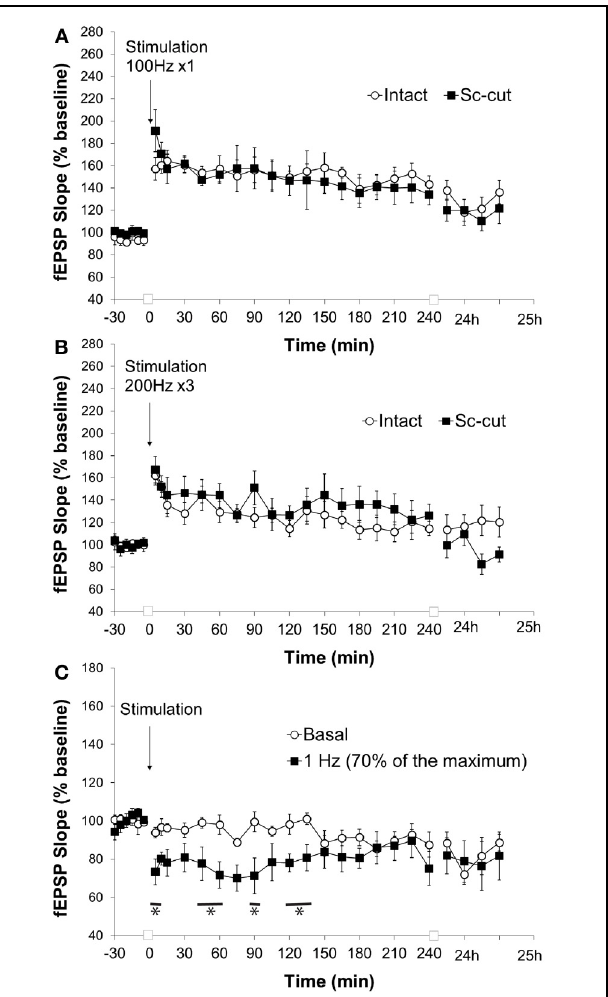
FIGURE 7 | Severence of CA3 input affects the response of the pp-CA1 synapse to LFS but not HFS. (A) High frequency stimulation (HFS) with a weak tetanus of 100Hz (1 burst of 100 pulses) resulted in potentiation in freely behaving rats with intact and Sc-cut conditions. (B) High frequency stimulation with a weak tetanus of 200Hz (3 burst of 15 pulses) resulted in potentiation in freely behaving rats with intact and Sc-cut conditions. (C) Low frequency stimulation (1Hz, 600 pulses) resulted in depression at the pp-CA1 synapse in freely behaving rats with a severed Schaffer collateral input compared to responses evoked in the same synapses by test-pulse stimulation (ANOVA). The lines marked with asterisks indicate individual time-points representing evoked responses after 1Hz stimulation that were determined to be significant from test-pulse evoked responses, using post-hoc Fisher’s LSD